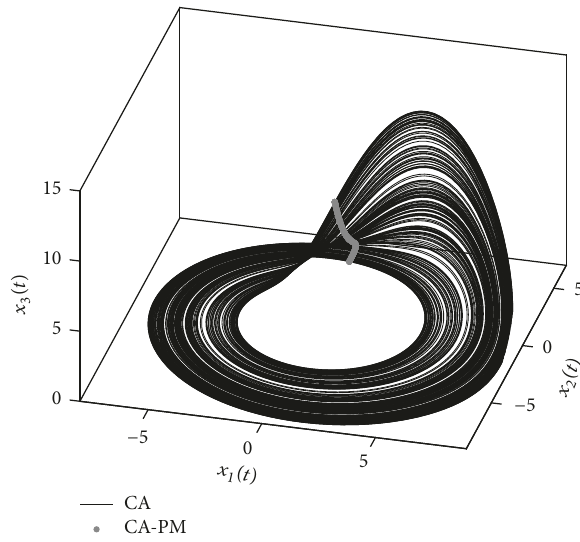
Figure 4: R¨ossler system chaotic attractor in continuous-time (CA) and Poincar´e map (CA-PM) for 𝛽 1 = 𝛽 2 = 0.2 and 𝛽 3 = 4.5